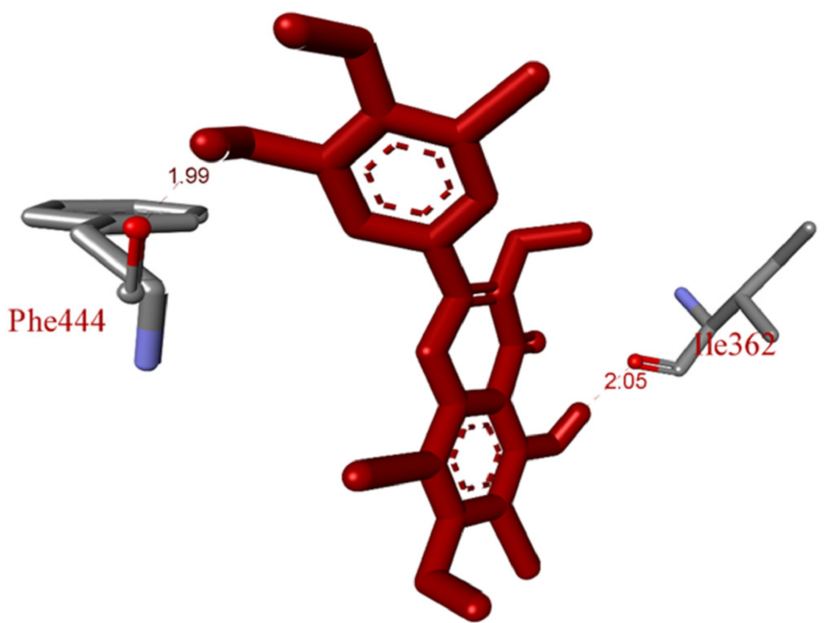
Figure 8. The hydrogen bonds were formed from residual amino acids of target enzyme 4J5T to functional groups on the most stable conformation ligand 8.